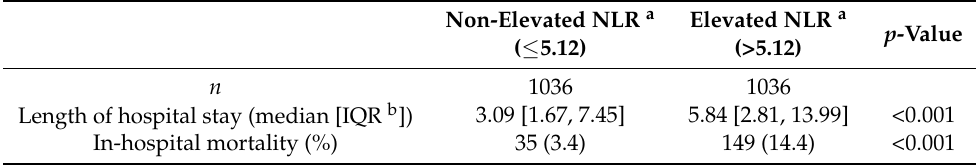
Table 3. Secondary outcomes of hospitalized patients with acute pulmonary